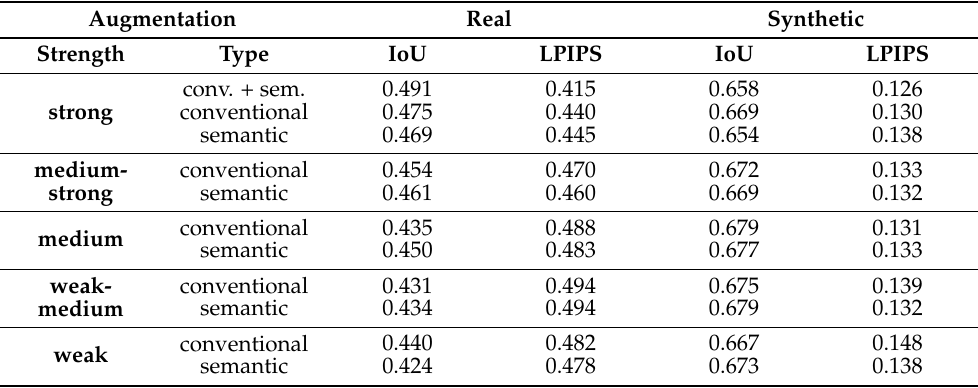
Table 2. Testing